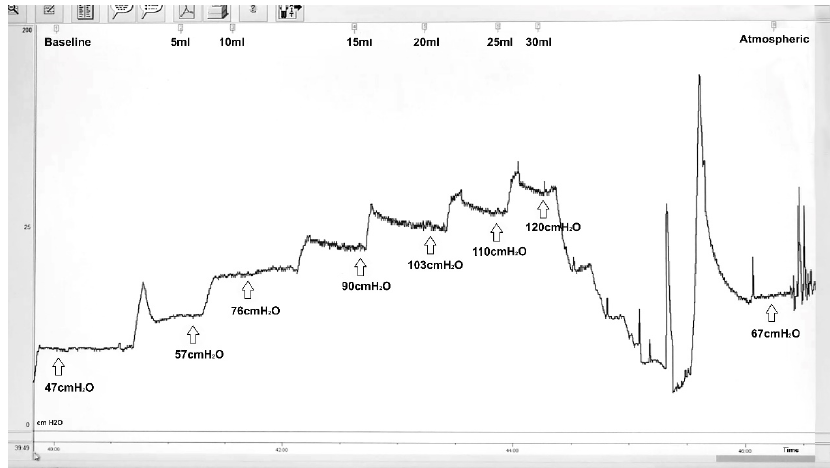
Figure 2. Example of continuous intraoperative registry that corresponds to patient ID 281568. ATOMS progressive filling with 5 mL serial increment from baseline to 30 mL is followed by total deflation and refill up to atmospheric pressure (Atmospheric). Intraurethral pressure in cm H2O (Y-axis) and filling volume in ml (X axis) are specified at each time point in the graph. In this patient, ATOMS cushion at atmospheric pressure with 8 mL increased urethral pressure to 67 cm H2O.